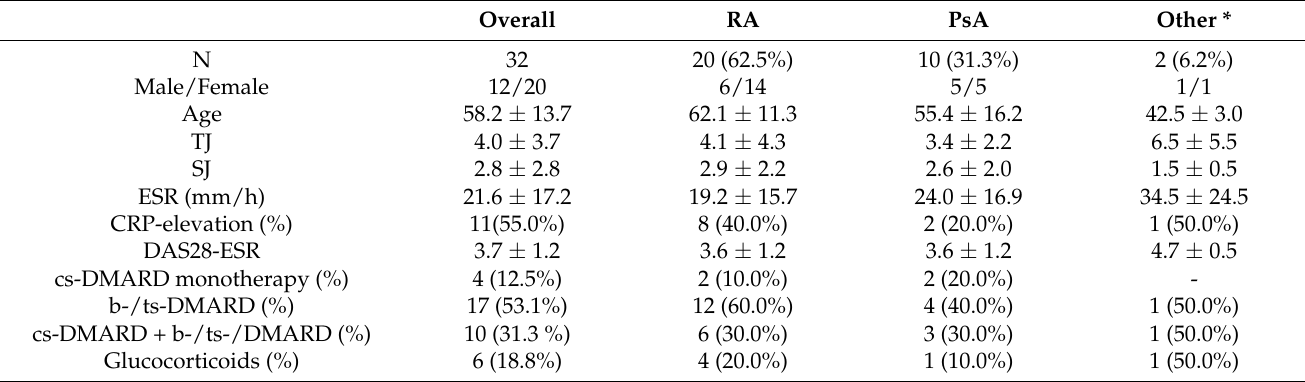
Table 1. Demographic and clinical